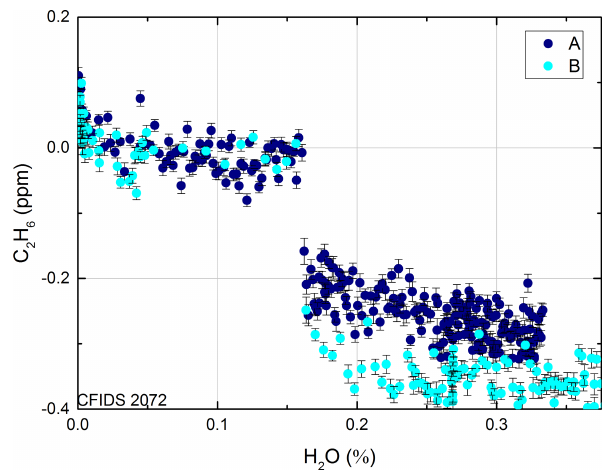
Figure 4. The discontinuity seen for instrument CFIDS 2072 for two repetitions denoted by different colours. After the discontinuity at 0.16% the subsequent slope clearly differs between the two rep- etitions. Both instruments display a discontinuity at 0.16% H 2 O. Each point represents a 1min average, the error bars represent the standard deviation of the raw